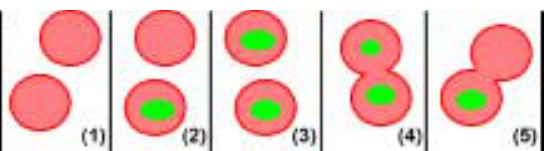
Fig. 8. Morphology of neighbouring erythrocytes. (1) Two sepa- rated cells without center, ρ s = 0 and ρ o ∼ 1. (2) Two separated cells with a clear center, ρ s = 0 . 5 and ρ o = 1. (3) Two sepa- rated cells with two centers, ρ s = 1 and ρ o = 1. (4) Two con- nected (overlapped) cells with two centers, ρ s = 2 and ρ o = 0 . 5. (5) Two connected (overlapped) cells with a center, ρ s = 1 and ρ o = 1. This figure can be viewed on http://www.esacp.org/acp/